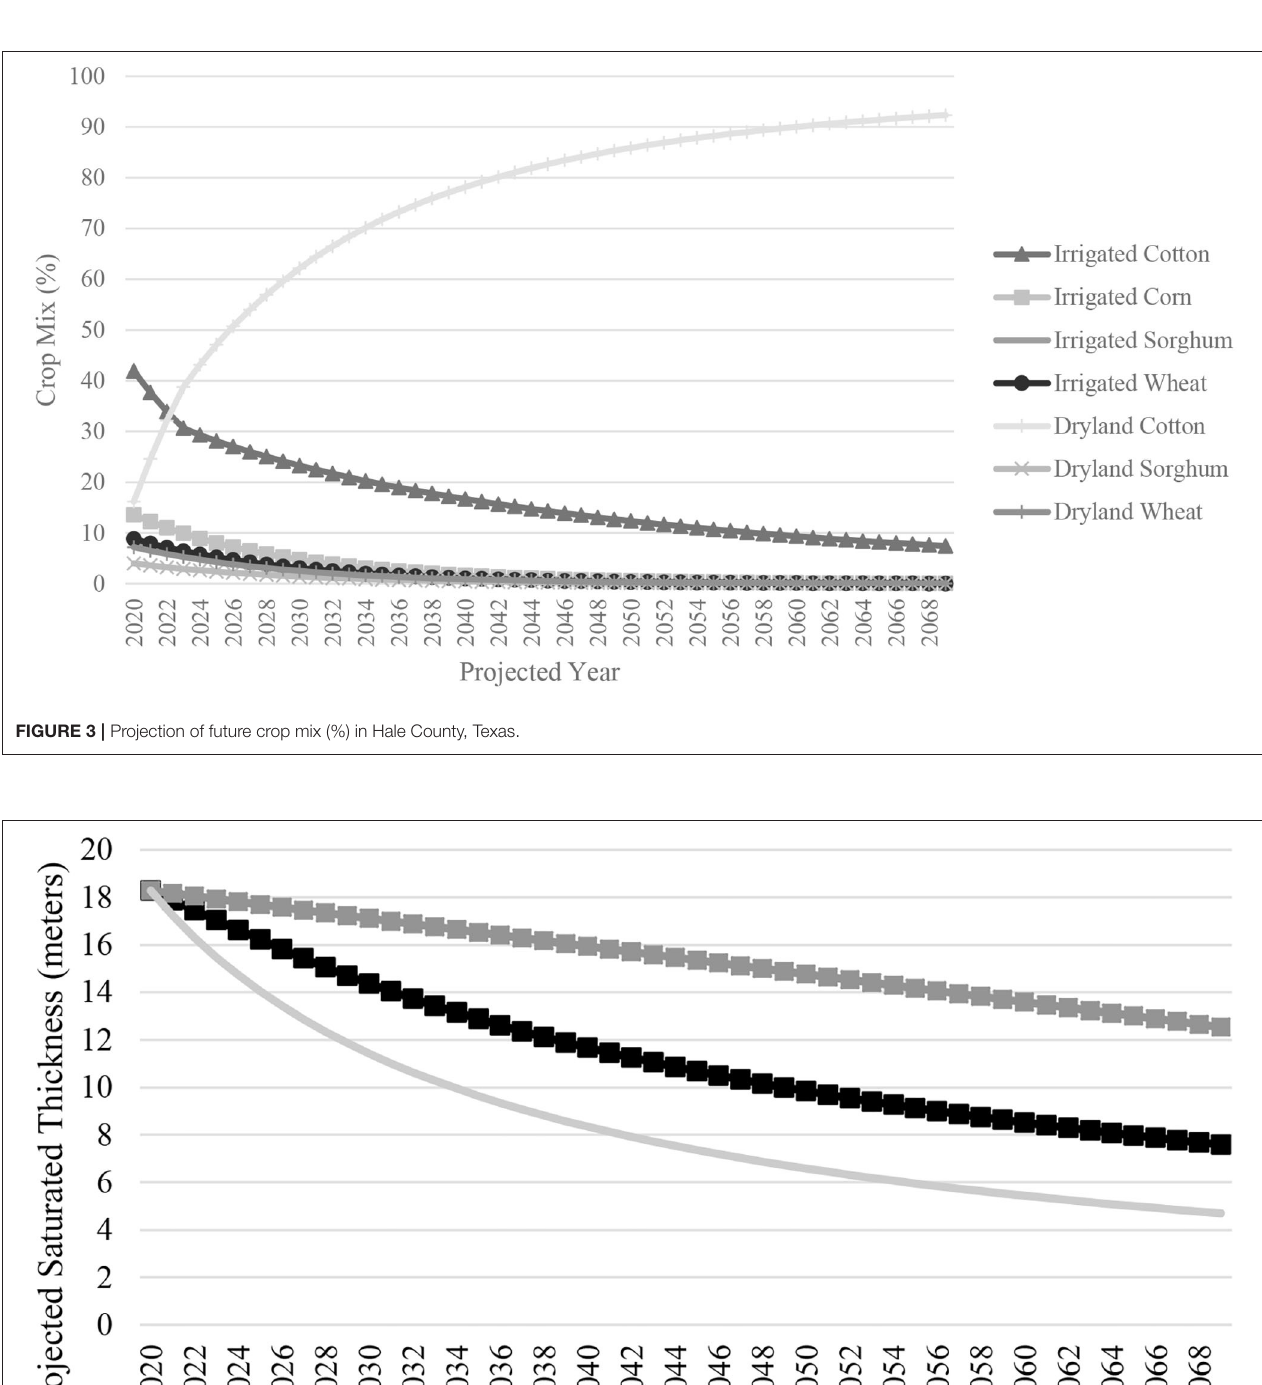
Frontiers in Sustainable Food Systems |